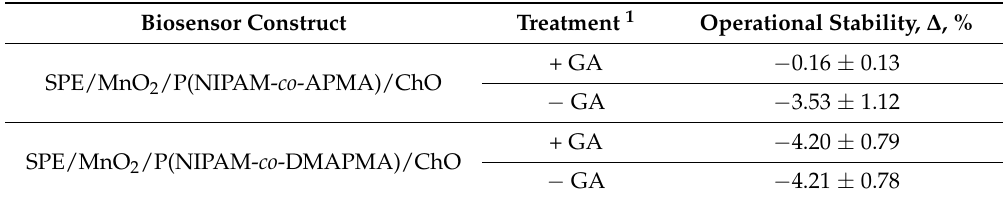
Table 3. Comparative operational stability of different biosensor constructs. Biosensor